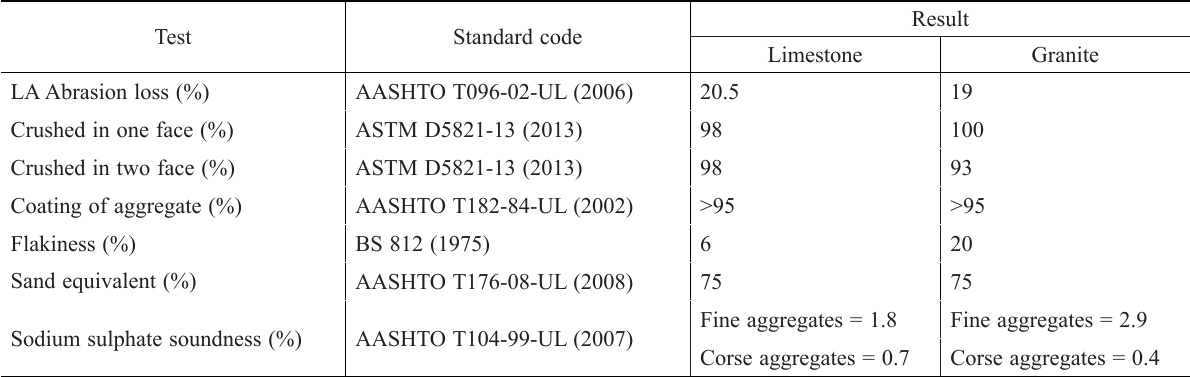
Table 2. Physical and mechanical properties of